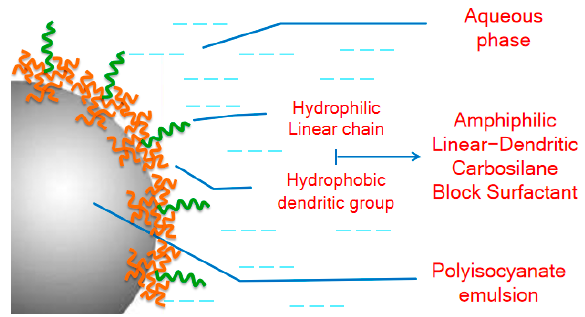
Figure 1. Schematic diagram of LDBS.